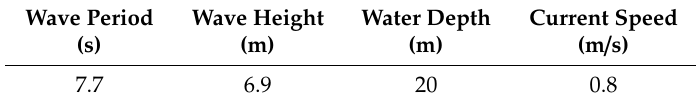
Table 3. Input data of marine condition in case study.